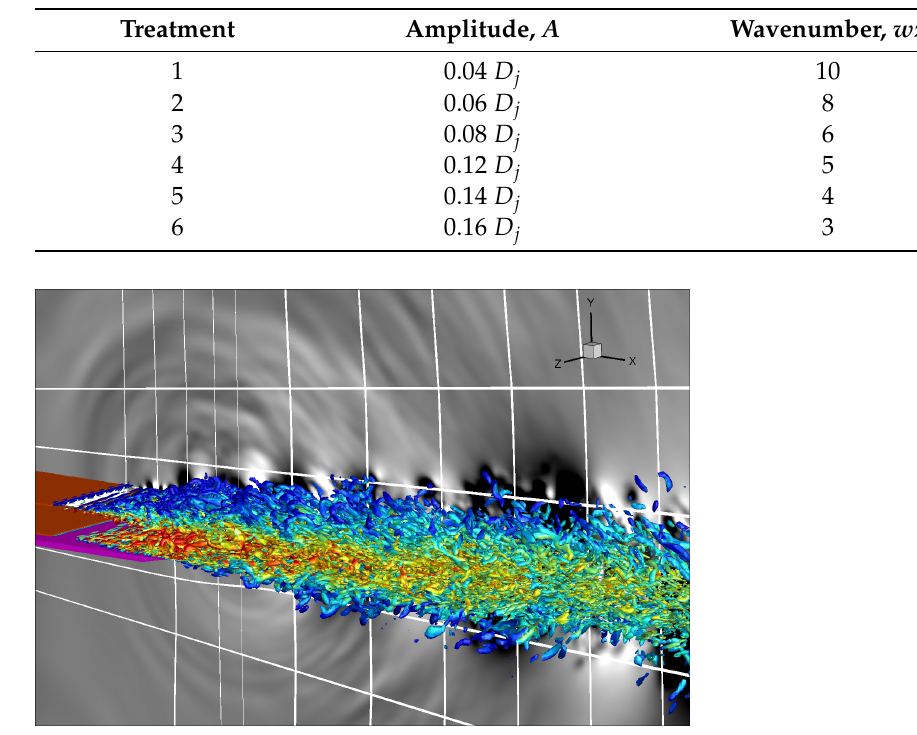
Table 2. Amplitudes and wavenumbers of the trailing edge.